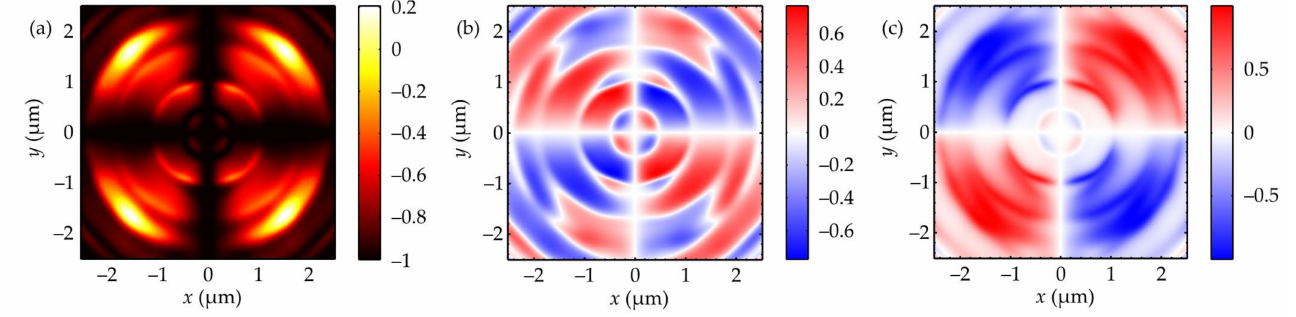
Figure 8. Components of the Stokes vector S 1 ( a ), S 2 ( b ) and S 3 ( c ) when calculating using FullWAVE software at a distance of 0.65 µ m after the actual focus.